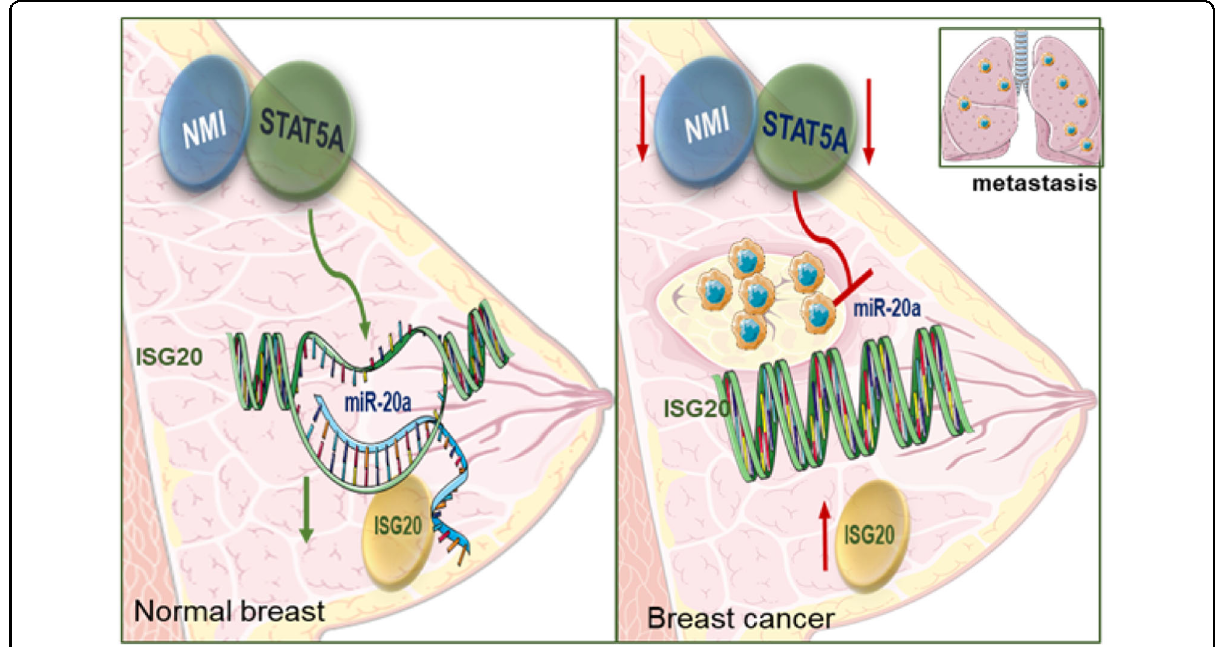
Fig. 7 Schematic summary of fi ndings. In normal breast NMI and STAT5A signaling keeps ISG20 expression in check, through expression of miR- 20a and cells undergo normal differentiation. In cancer, NMI and Stat5A expression is compromised that reduces the check on ISG20 expression. Increased ISG20 promotes invasive progression that leads to metastatic colonization at a secondary